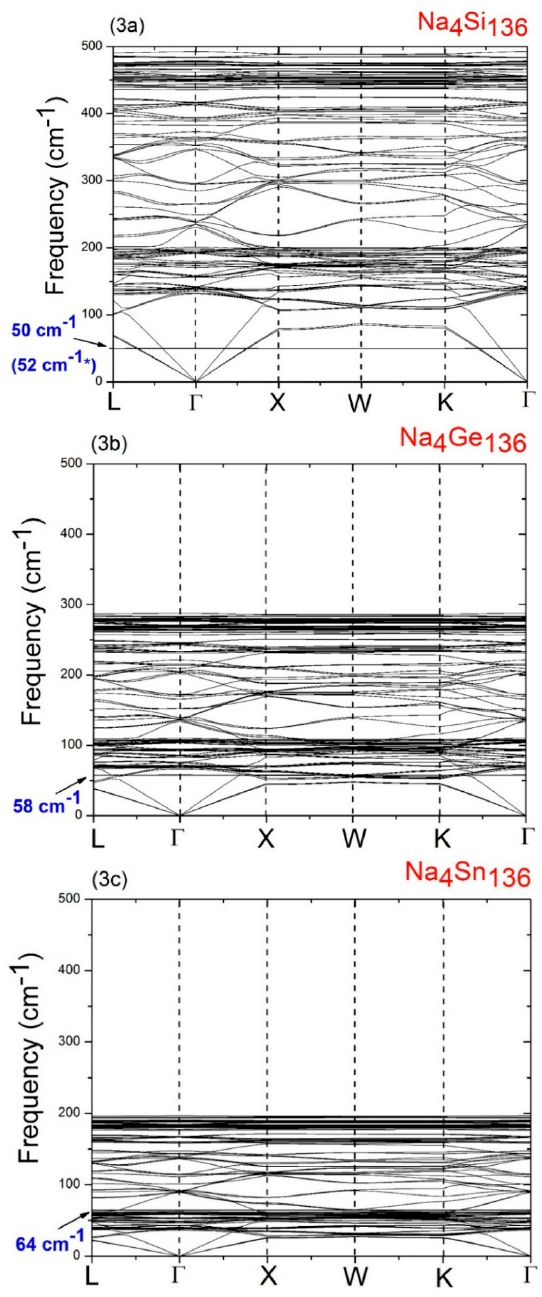
Figure 3. Calculated phonon dispersion curves for some of the Type II clathrate materials with four Na guests in the large, 28 atom cages. The predicted vibrational modes for Na 4 Si 136 , Na 4 Ge 136 , and Na 4 Sn 136 are shown in Figure 3 a – c , respectively. The number in parentheses is for the Na guest associated modes in Na 4 Si 136 , and was obtained from inelastic neutron scattering (INS) experiments [15].